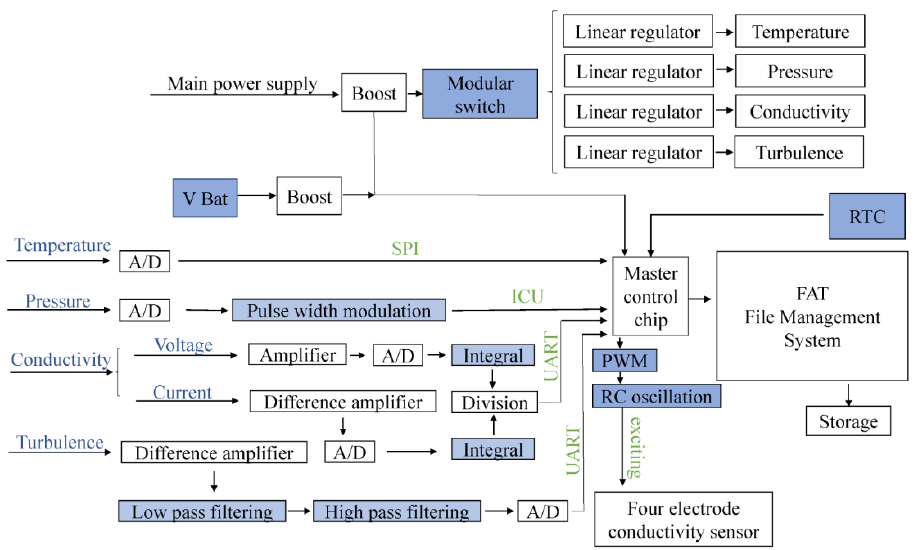
Figure 1. The overall hardware logic system.